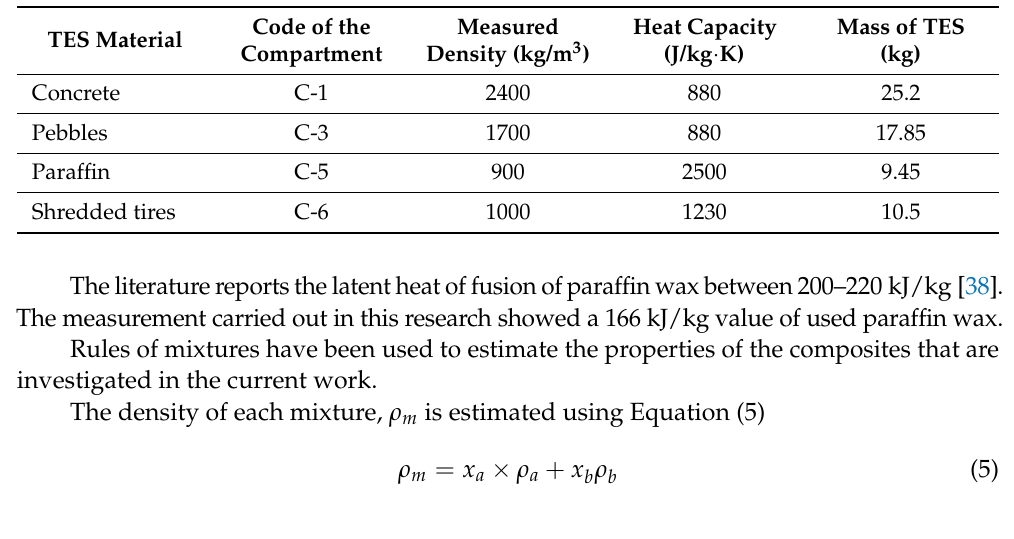
Table 3. Properties of the base materials used in the